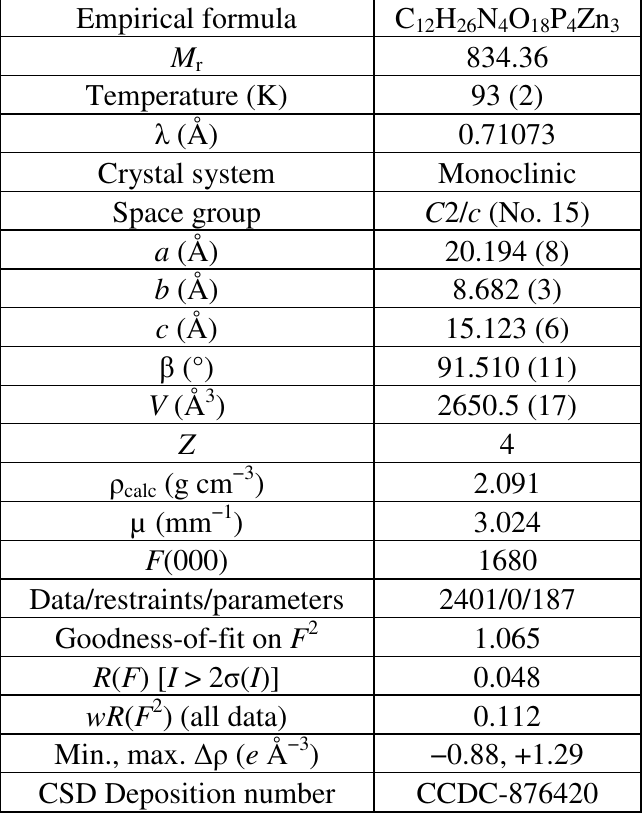
Table 3. Crystallographic parameters for 1